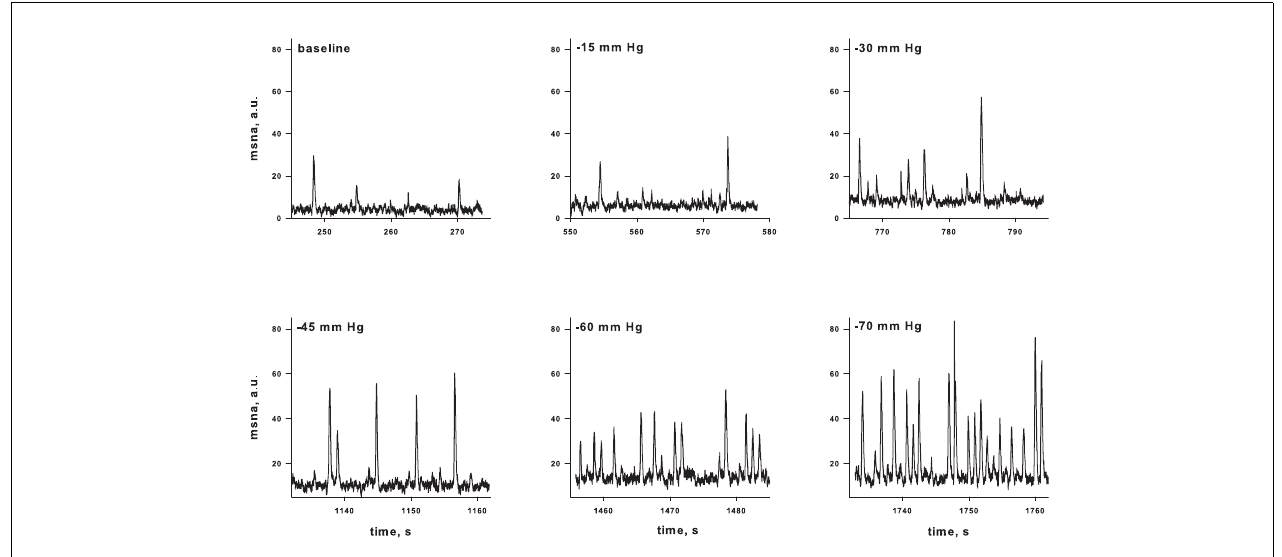
FIGURE 2 | Muscle sympathetic nerve activity (MSNA) in a representative subject during progressive lower body negative pressure. From Cooke et al. (2008).